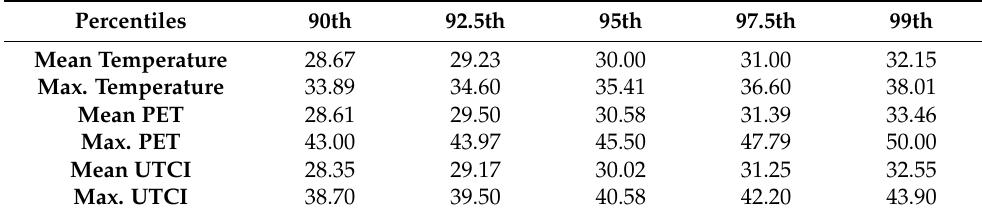
Table 2. Percentiles (Unit: ◦